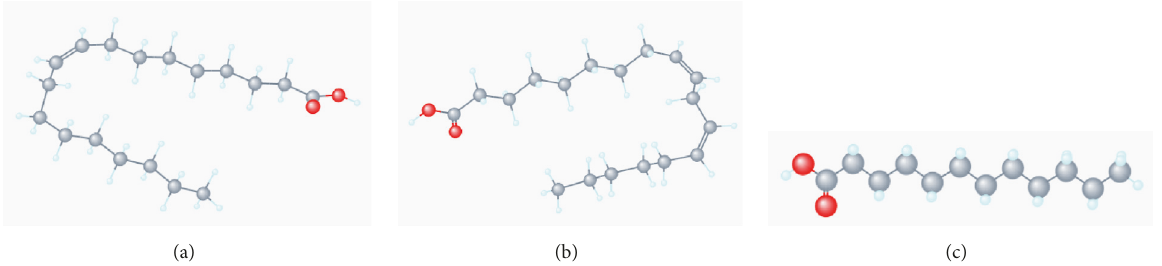
Figure 7: (a) Oleic acid [12], (b) linoleic acid [13], and (c) lauric acid [14].